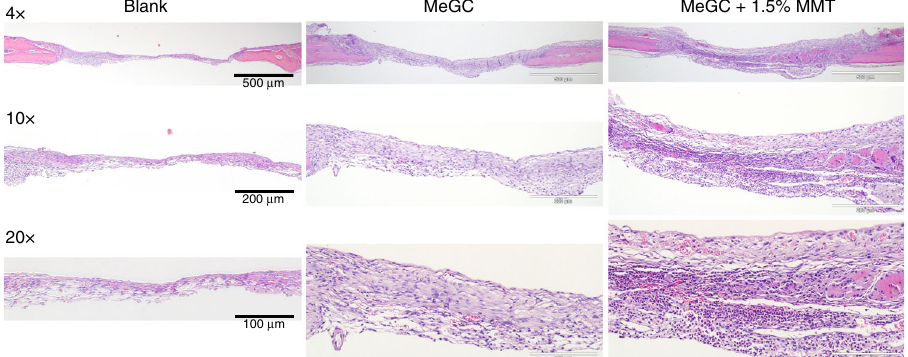
Fig. 7 In vivo cell in fi ltration assessment. Histological analysis of native cell in fi ltration in the hydrogels with hematoxyline and eosin (H&E) staining in calvarial defects, 10 days post